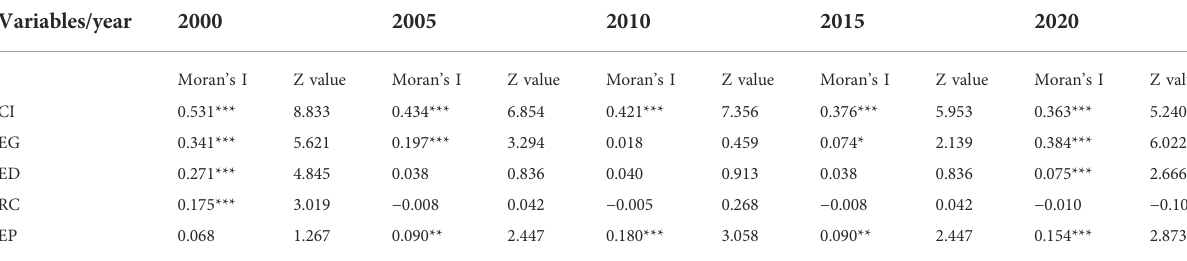
TABLE 7 Moran index calculation results.